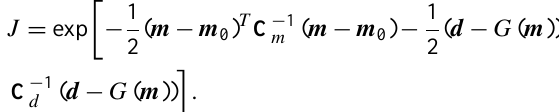
prior model ( m 0 ) and covariance matrices of the measure- ments ( C d ) and of the prior model ( C m ), the conventional least-squares solution is obtained by maximizing the objec- tive function J given by Tarantola (2005) (or by minimizing the exponent in the expression, − log( J